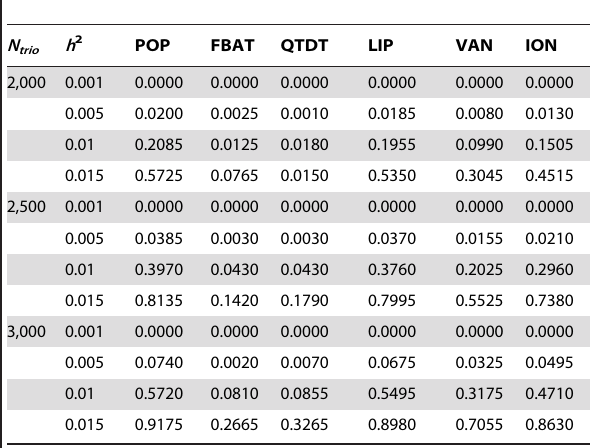
Table 4. Empirical power for GWAS under no population stratification.